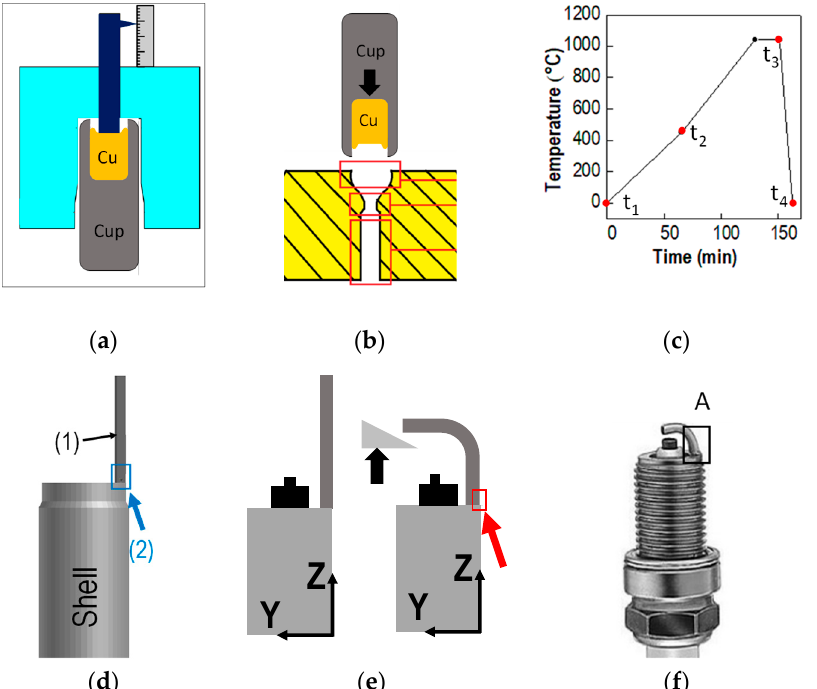
Figure 1. Manufacturing processes of a ground electrode. ( a ) Tamping of the copper in Inconel 601 cup, ( b ) cold working of the assembly, ( c ) annealing: temperature variation, ( d ) welding of the ground electrode to the steel shell [5], (1) and (2) indicate respectively the ground electrode and the welded zone, ( e ) bending inducing cracks (red rectangle), ( f ) final spark plug with crack in A.